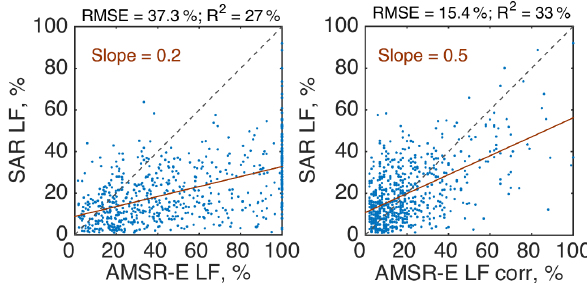
Figure 10. Left: scatter plot of SAR LF and AMSR-E LF using the original method of Röhrs et al. (2012). Right: same but using the adjusted AMSR-E method (new tie point). The 1-to-1 lines are the dashed grey lines, and the linear regressions are shown by the red lines and the values of the slope. The root mean square error (RMSE) and the coefficient of determination ( R 2 ) are shown at the top of the